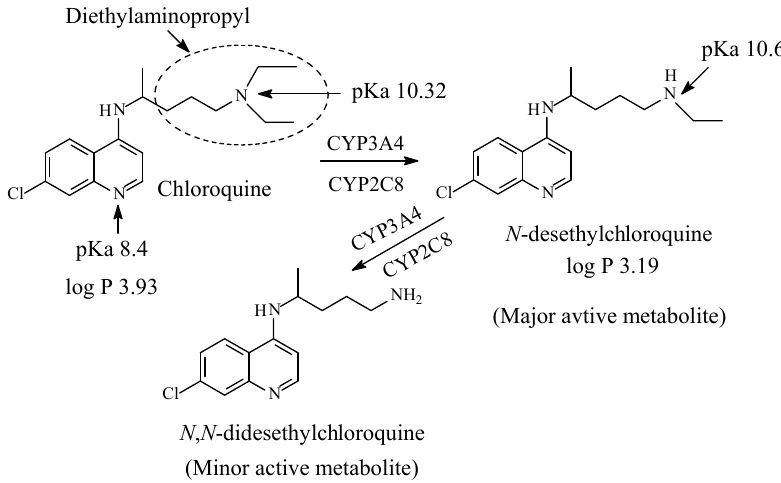
Figure 38. Major metabolic pathways of chloroquine.